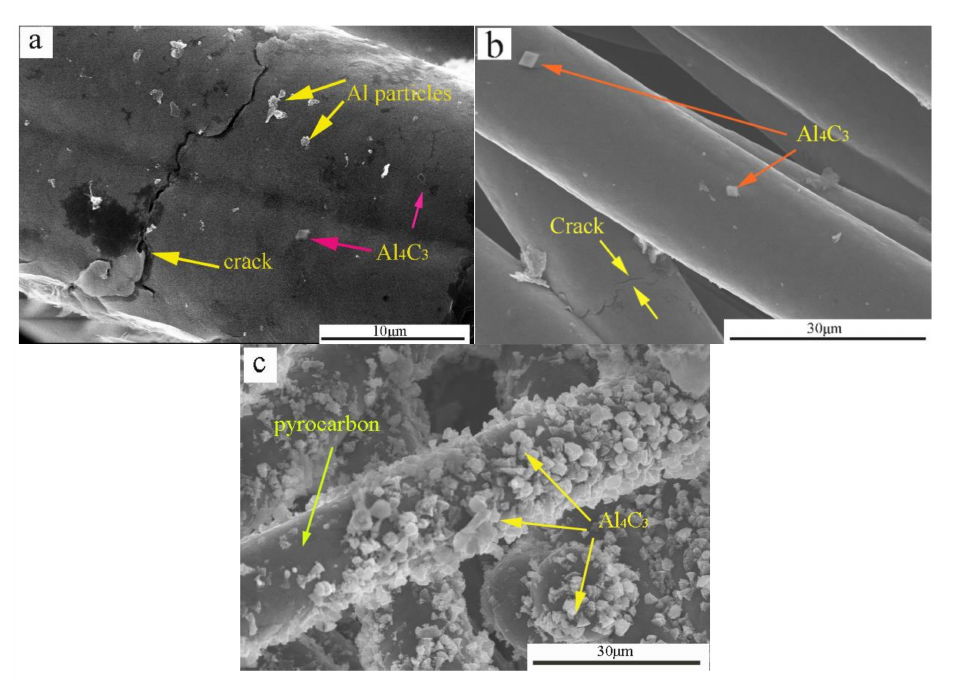
Figure 11. Morphology of pyrolytic carbon of carbon fibers covered with Al particle and a small quantity of Al 4 C 3 . ( a , b ) reacts with pyrocarbon early, and ( c ) reacts with pyrocarbon at the